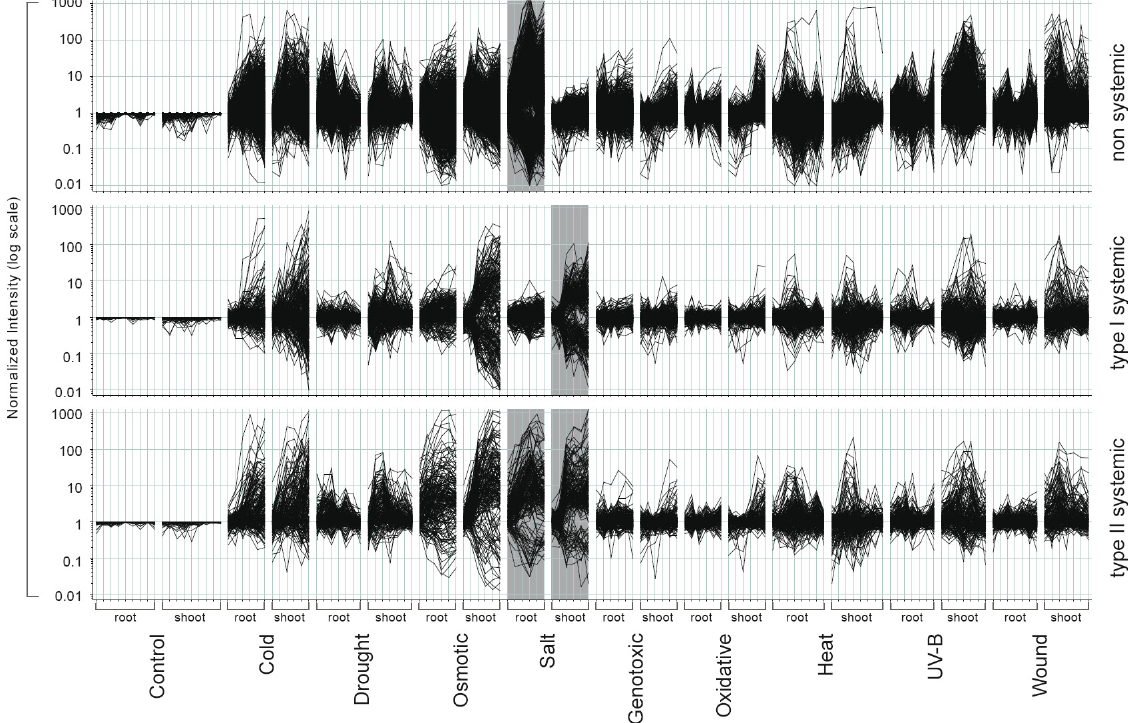
Figure 5. Expression profiles of salt stress response genes. Genes of the non-systemic, type I systemic and type II systemic salt stress response are visualized for all nine treatments of the AtGenExpress abiotic stress experiment. Each line represents the expression trajectory of one gene for each stress condition, in each tissue and along all points in time. The grey bar indicates those genes of the salt stress response that were used as input. Each of the three panels displays individually the non-systemic, systemic type I and systemic type II salt response genes that passed our strict filtering